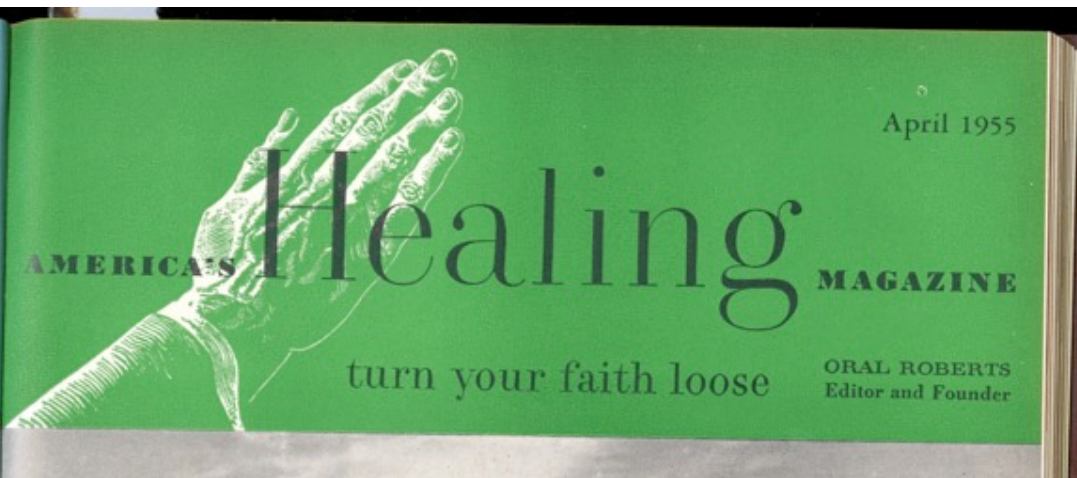
Figure 6 . This image of a spectral hand was featured on many of the front covers of America’s Healing Magazine.